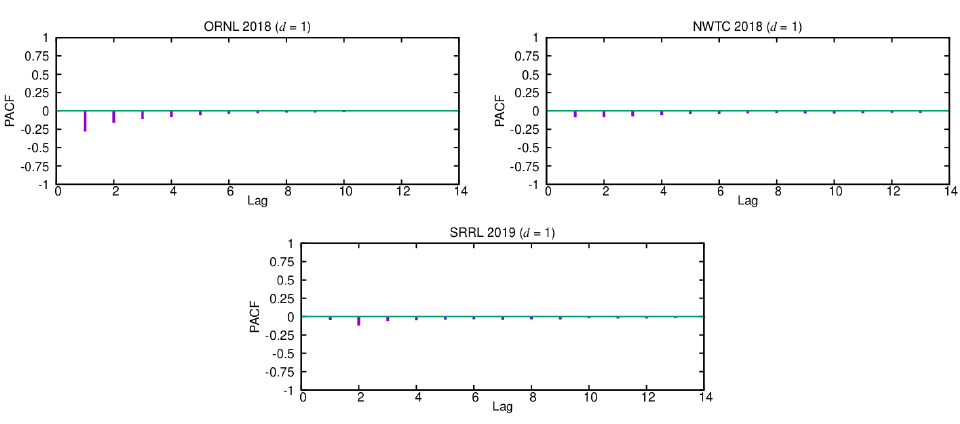
Figure 3. Partial autocorrelation functions (PACFs) for d =